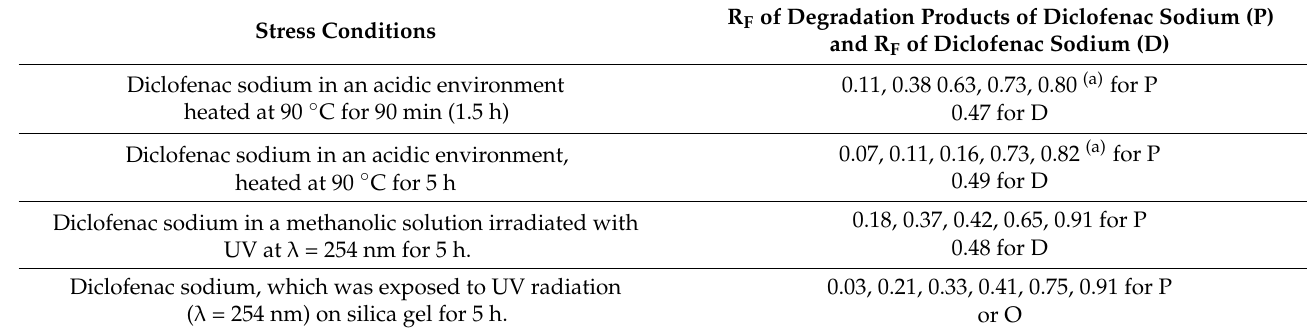
Table 3. R F values for diclofenac sodium and diclofenac degradation products a) after analysis on silica gel using the cyclohexane – chloroform – methanol – glacial acid acetic acid (6:3:0.5:0.5, v / v / v / v ) [48].